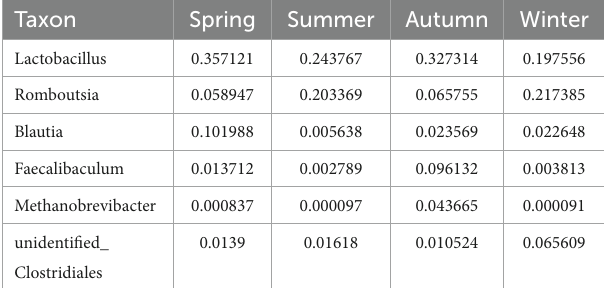
TABLE 3 The microbes with a higher relative abundance at the genus